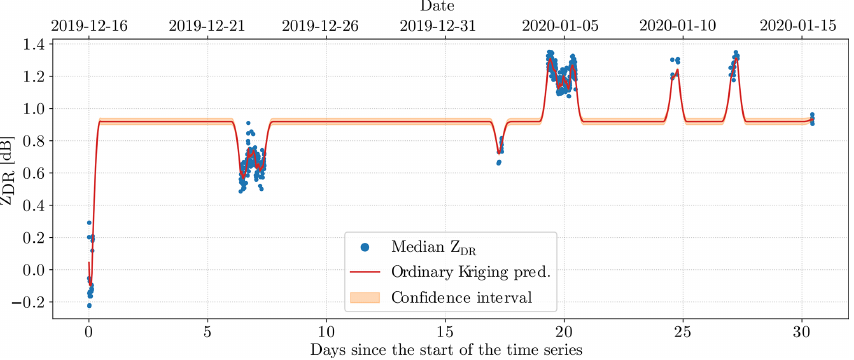
Figure 3. Time series of the differential reflectivity bias computed for MXPol. The continuous red line illustrates the final bias provided by the kriging interpolation, its uncertainty interval is highlighted in orange, and the median offset derived from each vertical scan is displayed as blue